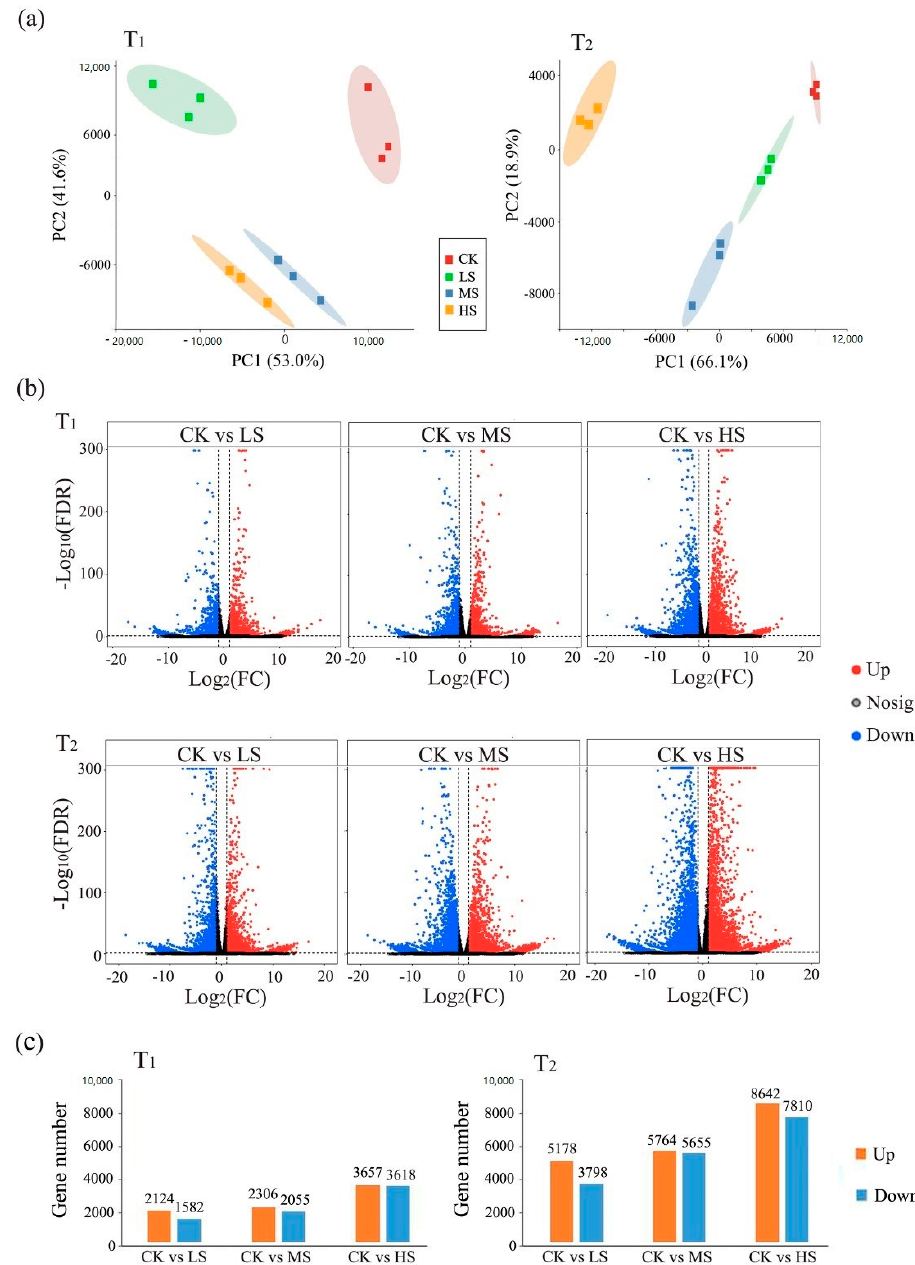
Figure 3. PCA score plots of gene expression, volcano plots of differentially expressed genes (DEGs), and the number of DEGs between different treatments at each sampling time. ( a ) Each point in the PCA score plot represents an independent biological replication, where red, green, blue, and yellow indicate CK, LS, MS, and HS, respectively; ( b ) Volcano plot of the DEGs (|Log2FC| > 1 and FDR < 0.05) between CK and the different salt treatments; ( c ) The numbers of DEGs between samples from different treatments (see Figure 1 for sampling time and treatments